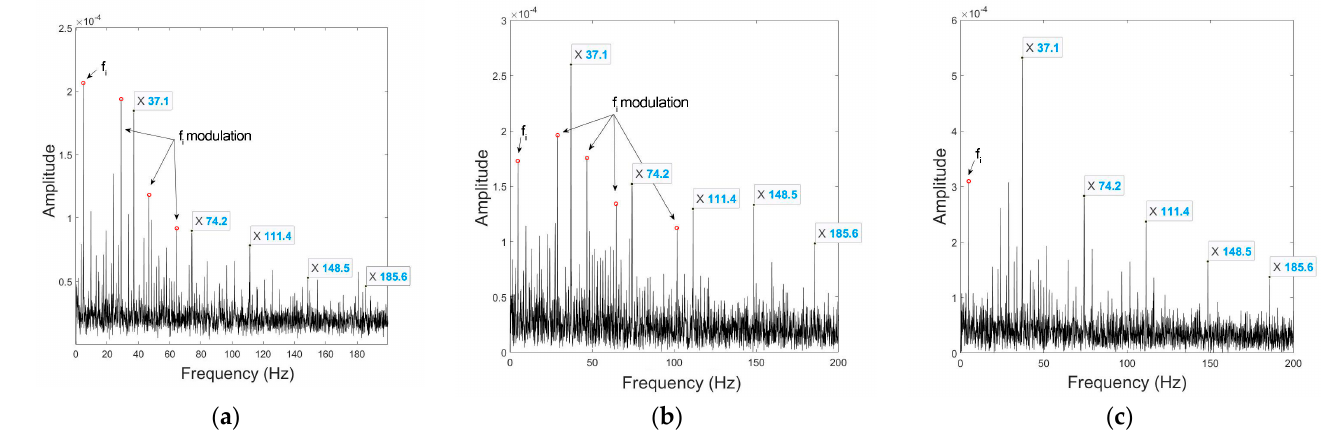
Figure 9. Envelopes under inner race fault condition at 290 rpm of: ( a ) non − processed mono signal; ( b ) UCMA − ESPRIT beamformed signal; ( c ) CPCMA − ESPRIT beamformed signal.